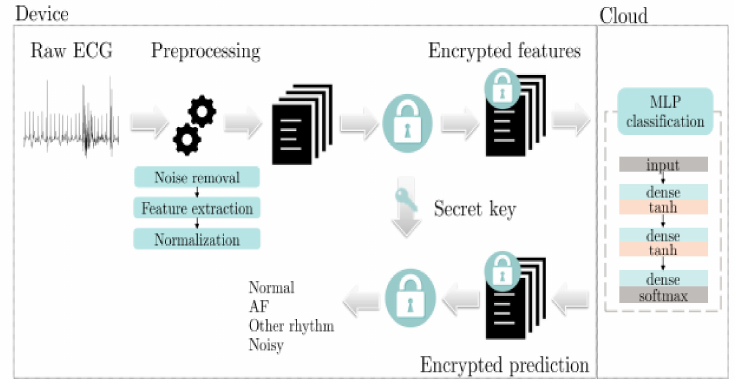
Figure 1. Workflow of privacy-preserving feature-based ECG classification method